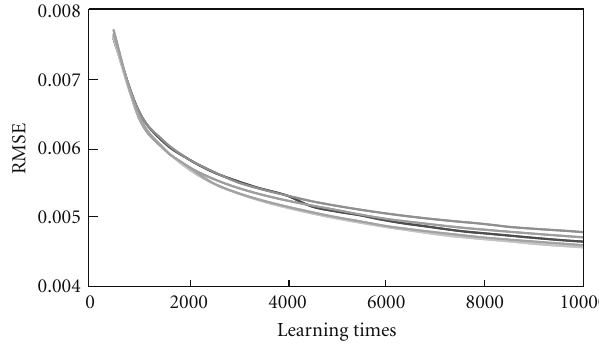
Figure 9: Changes in